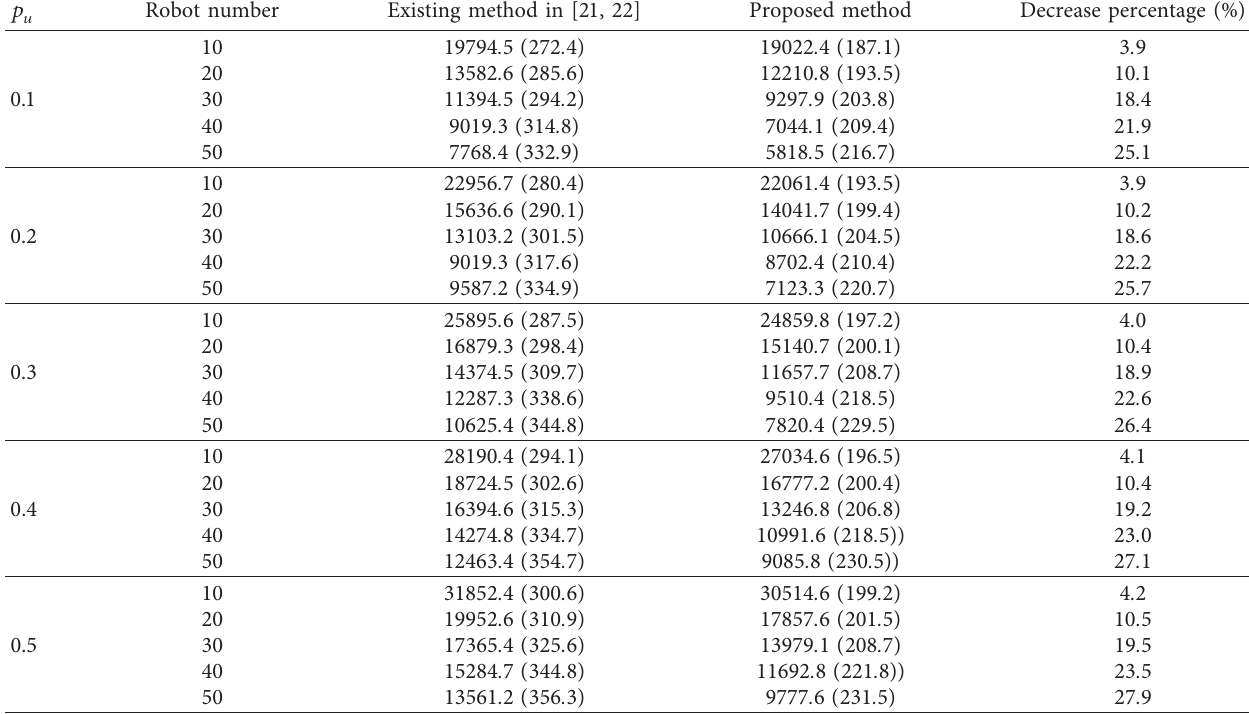
Table 2: Simulation results in a warehouse environment of 50 × 34 4-neighbor grids: makespan (standard deviation). p u Robot